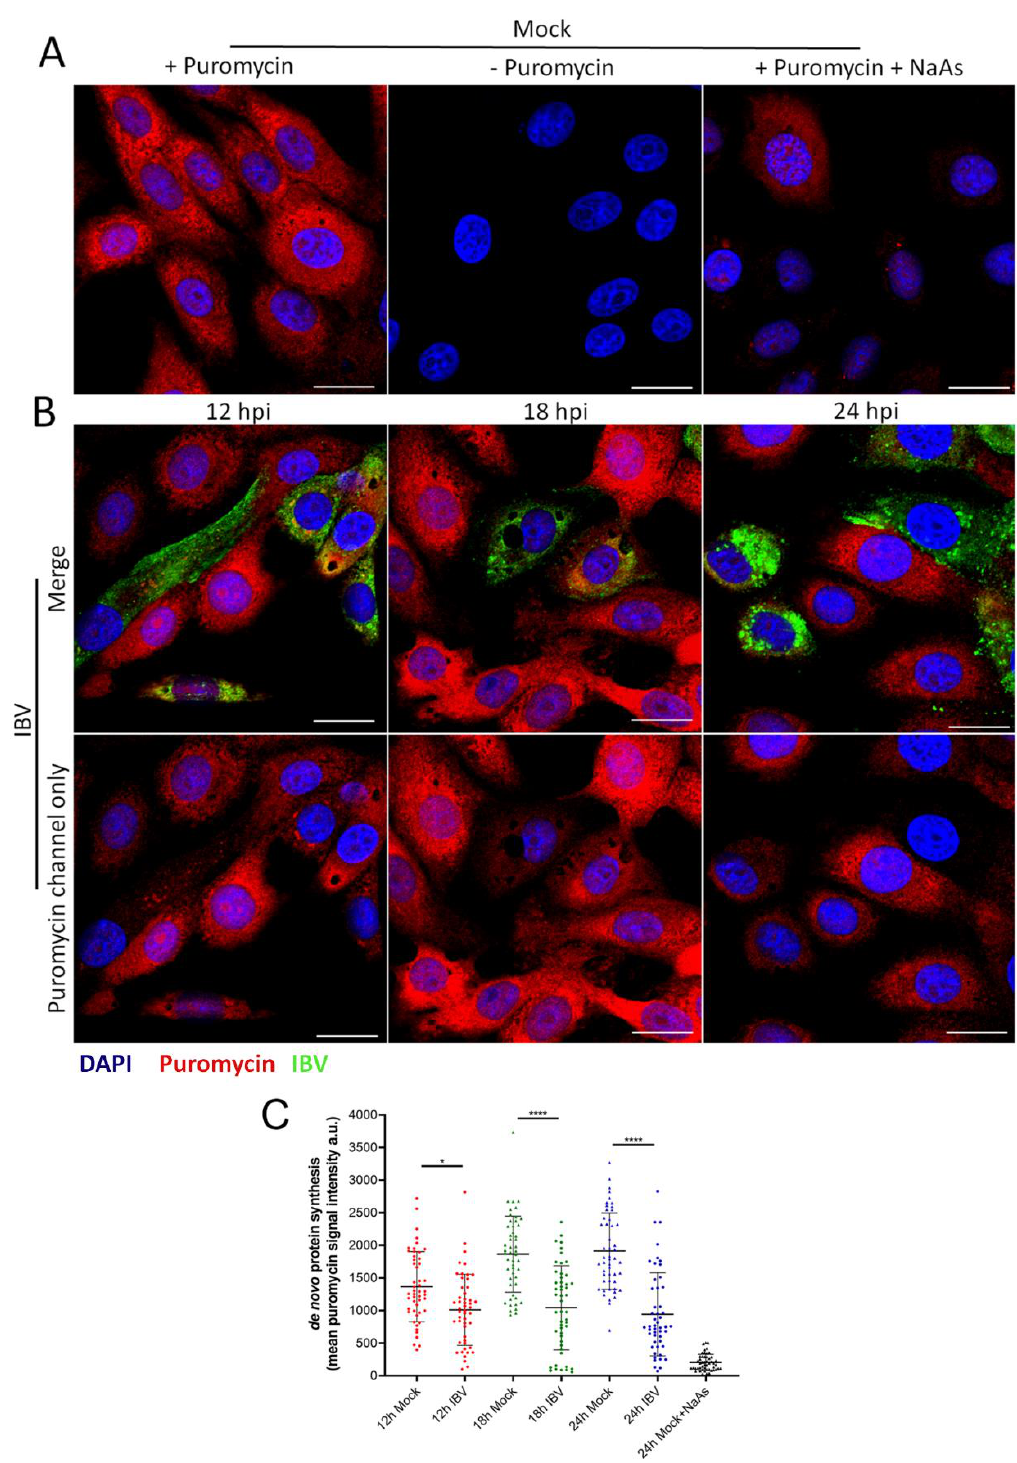
Figure 7. IBV infection results in translational shut-o ff . Vero cells were mock infected ( A ) or infected with IBV ( B ). At 23 hpi, positive control cells were treated with sodium arsenite (NaAs) to induce inhibition of translation. At 12, 18 and 24 hpi cells were treated with puromycin (or –puromycin) followed by emetine. Cells were then fixed, and nascent polypeptides were labelled with puromycin detected using an anti-puromycin antibody (red) and IBV infected cells were labelled with an anti-IBV antibody (green). Nuclei were stained with DAPI (blue). Scale bar indicates 20 µ m. ( C ) Representative scatterplot of de novo protein synthesis from ( A ) and ( B ), measured by fluorescence intensity of the puromycin signal, analyzed in 50 cells. Data presented is representative of three